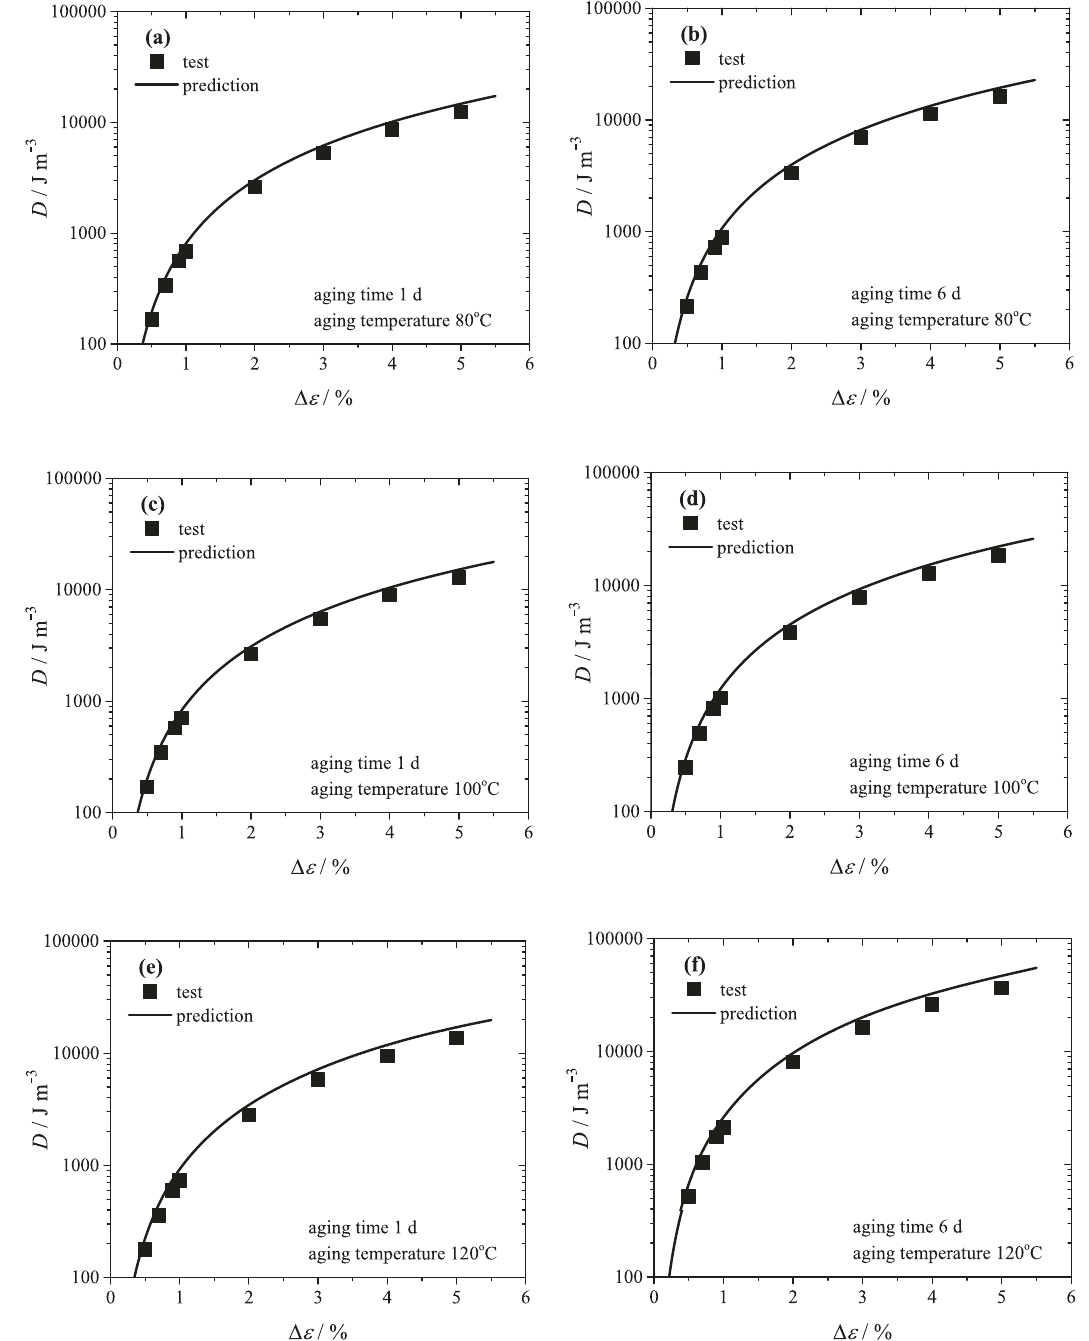
Fig. 9 Hysteresis loss prediction results vs. experiments. Scatters are the experimental results, and solid lines are the model prediction results. a , b The results for aging temperature 80 ℃ , c , d the results for aging temperature 100 ℃ , e , f the results for aging temperature 120 ℃